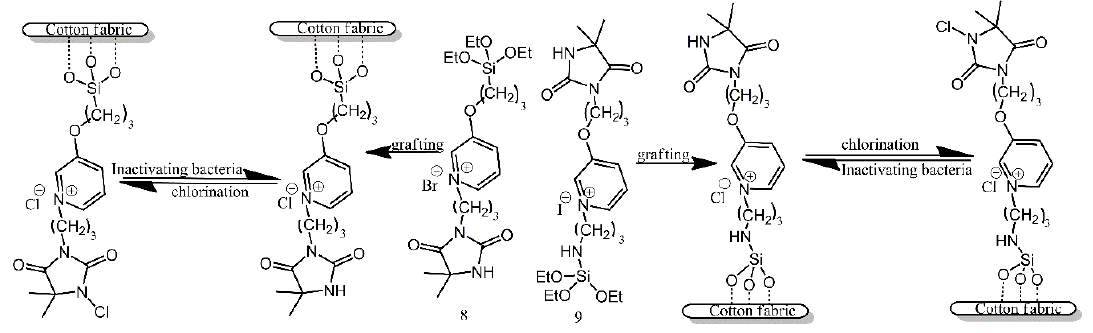
Figure 8. Schematic illustration of cotton fabric grafting and chlorination. Based on Ref. [6].